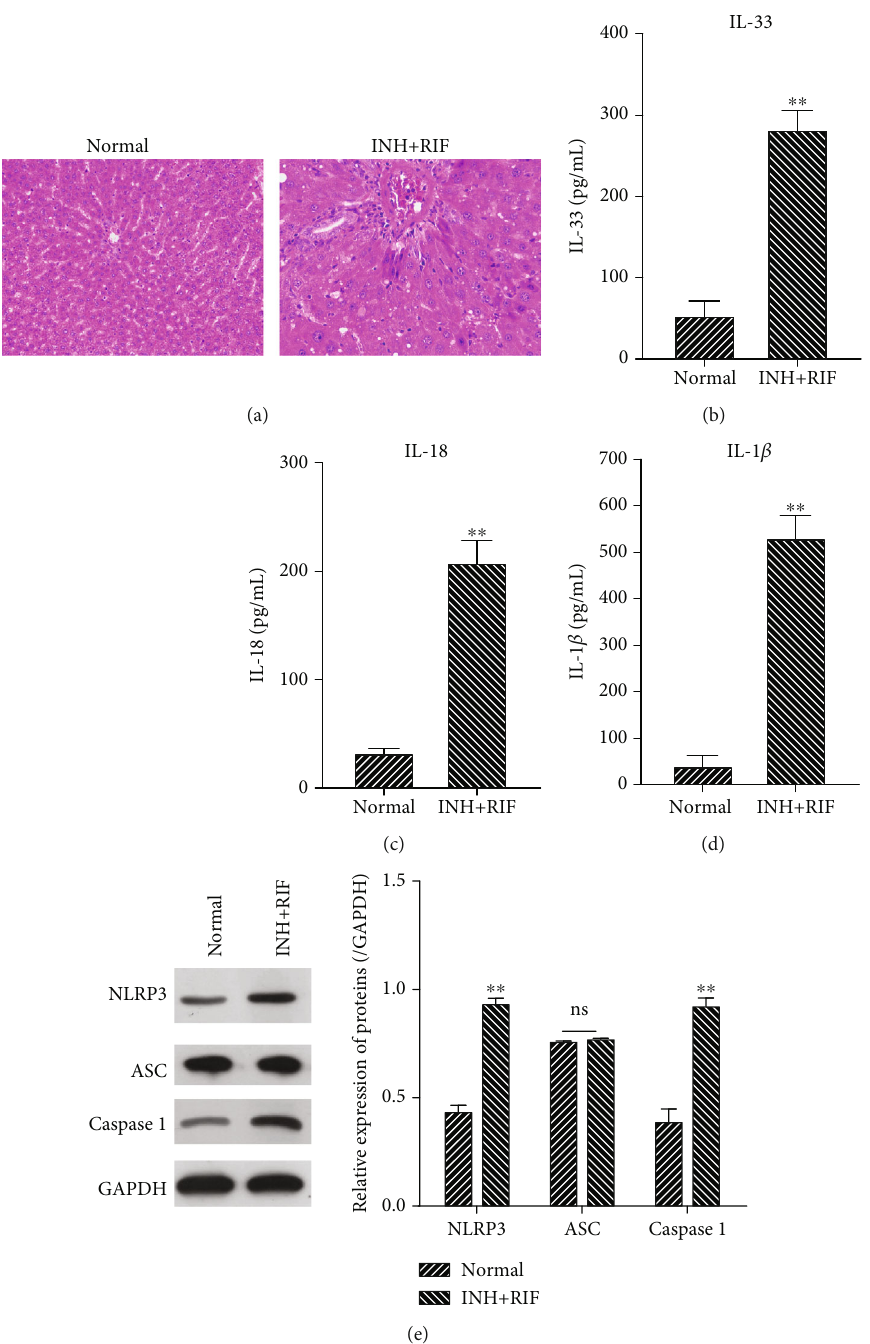
Figure 1: INH and RIF induced liver injury, enhanced the in fl ammatory response, and activated NLRP3 in fl ammasomes in rats. Rats were administrated 70 mg/kg INH and 70mg/kg RIF for 28 consecutive days. (a) The liver tissues in each group were collected, and histopathological changes in the liver tissues were observed after H&E staining. Samples of blood serum were obtained from each group of rats; the levels of IL-33 (b), IL-18 (c), and IL-1 β (d) in serum were detected by ELISA. (e) Western blot assays were performed to verify the levels of NLRP3, ASC, and cleaved-caspase 1 protein expression in each group of liver tissues. GAPDH served as an internal reference. A quantitative analysis of each protein expression was conducted according to the gray value. ∗∗ P < 0 : 01 vs. the normal